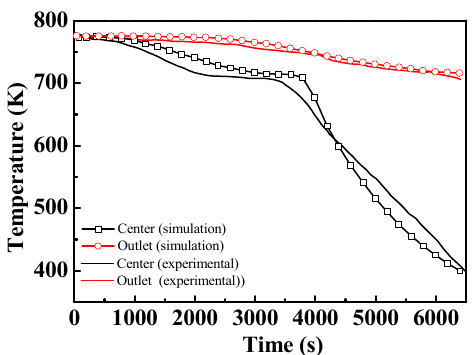
Figure 5. Comparison between the experimental and modelling results for the center and the outlet.